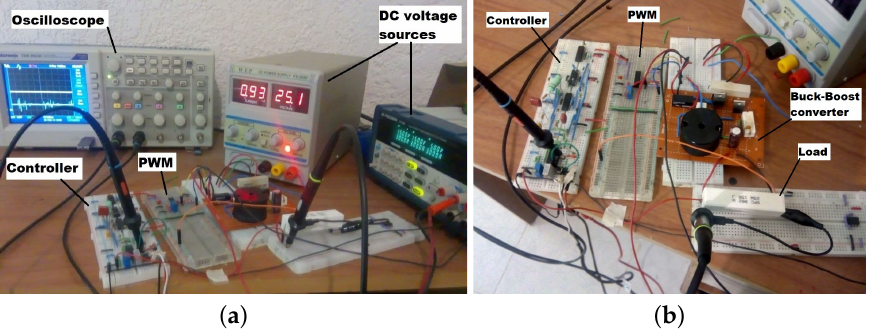
Figure 11. ( a ) Experiment table with oscilloscope, DC voltage sources and the electrical system. ( b ) Electrical system composed of fractional-order controller approximation, pulse width modulation (PWM) generator and buck–boost converter with the corresponding